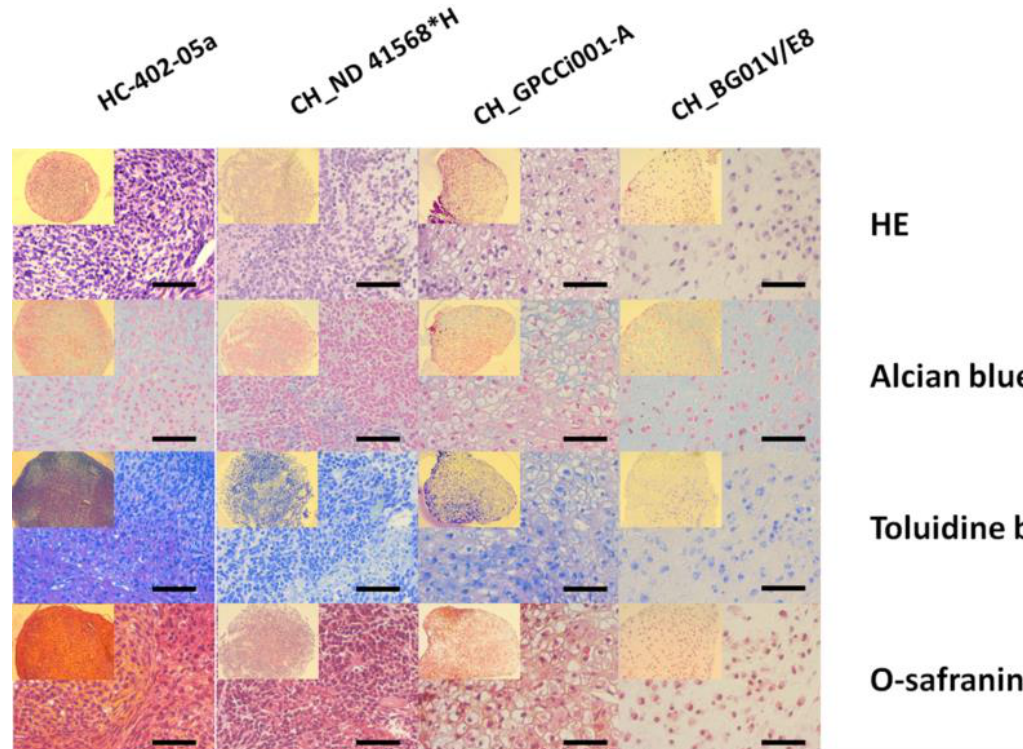
Figure 6. The 3D pellet culture produced premature chondrogenic like spheres. Histochemical staining for ECM has indicated the chondrocyte-like morphology of differentiated pluripotent stem cells after 35 days of chondrogenic differentiation (2 weeks in 3D culture). The positive staining for alcian blue, toluidine, and O-safranin was observed in derived chondrogenic-like spheres, but not intense like in the control population HC-402-05a cultured in 3D. The black scale bars represent 50 μm.